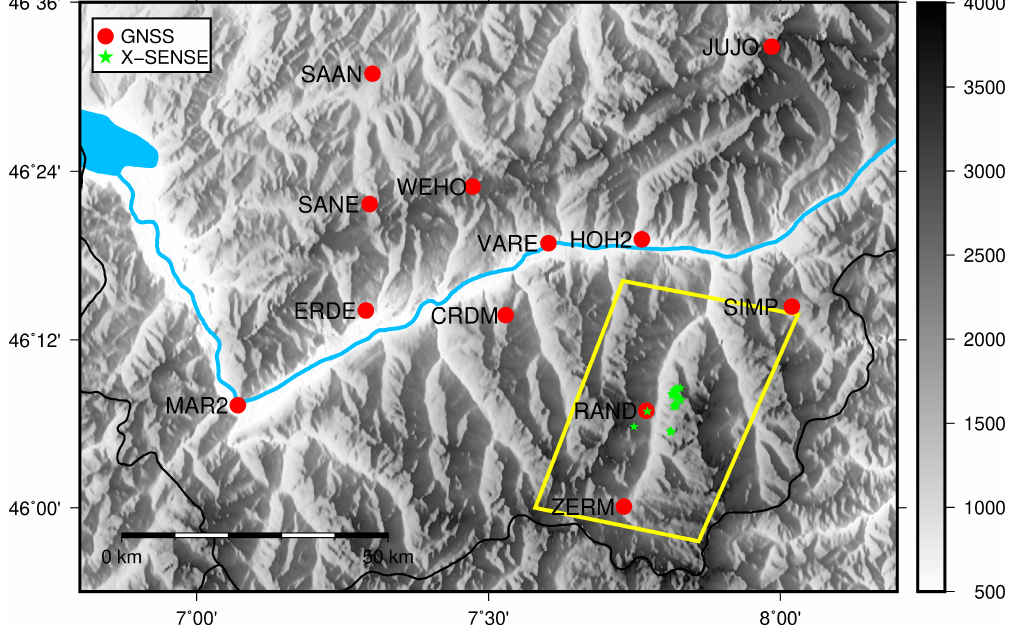
Figure 2. Locations of the GNSS stations in the alpine region of Valais superimposed with NASA ASTER Global Digital Elevation Model (GDEM). The yellow parallelogram indicates the footprint of COSMO-SkyMed SAR acquisitions used in this